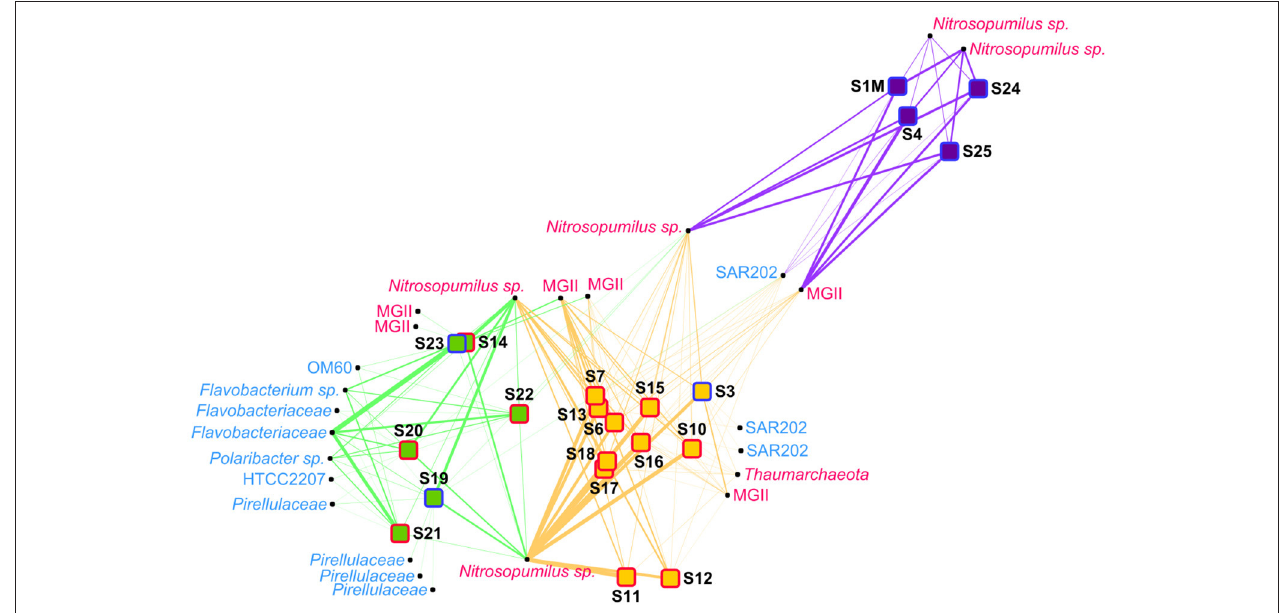
FIGURE 3 | Network analysis of the prokaryote samples. The samples were distributed using a “force-directed” paradigm on prokaryotic OTU distributions. The width of the edges represent the abundance of the OTU within a sample. Archaea are written in pink and Bacteria are written in light blue. Purple squares, group P1 samples; orange squares, group P2 samples; green squares, group P3 samples; red border, plume sample; blue border, background sample.